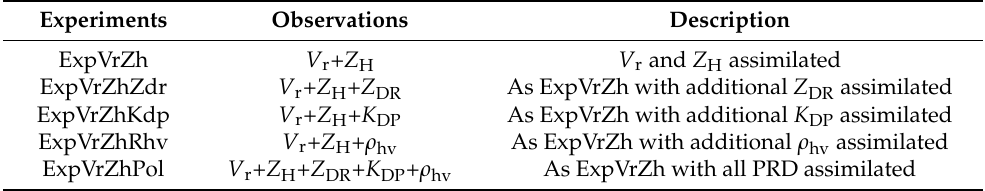
Table 2. List of experiments.